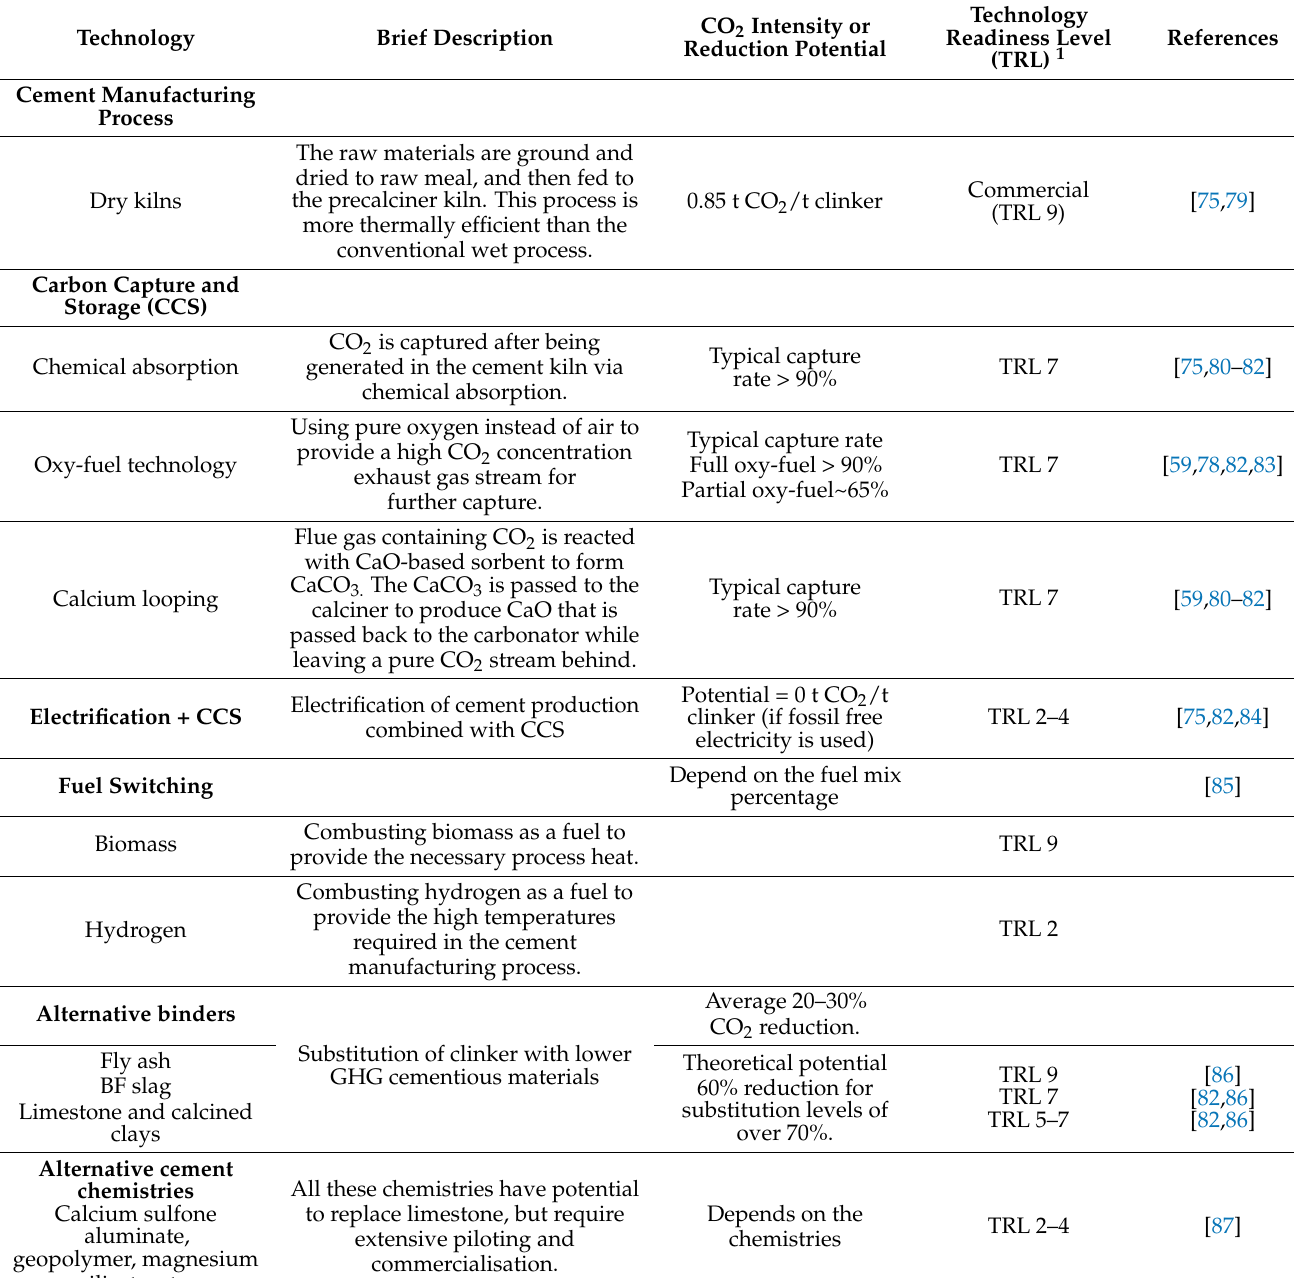
Table 2. Technical options for decarbonisation of cement industry including CO 2 reduction potential and technology readiness levels (TRLs). See [49] for a description of the